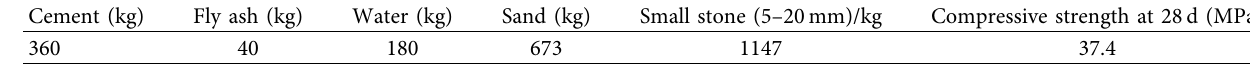
Table 1: Mix proportions and the major parameters of C30